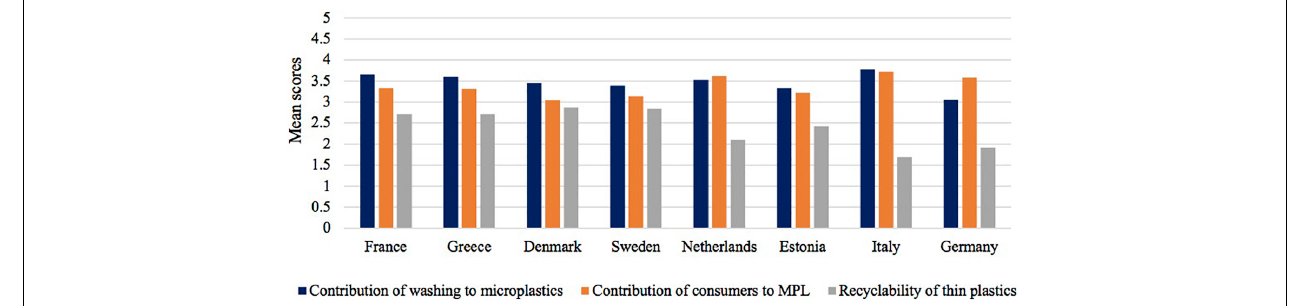
FIGURE 7 | Mean scores of respondents’ level of knowledge and understanding across three plastic pollution themes. Scores range from 1 = low level of knowledge to 5 = high level of knowledge related to the following statements: “ Washing synthetic clothing is a significant contributor of microplastic litter ,” overall M = 3.5